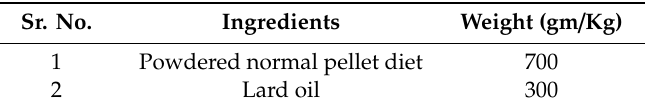
Table 1. High fat diet (HFD) composition.